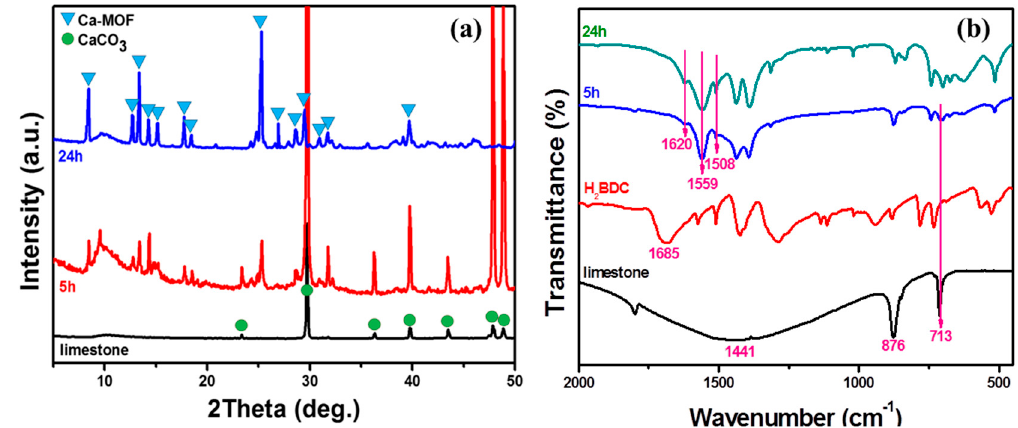
Figure 1. ( a ) XRD patterns and ( b ) FTIR spectra of limestone acidified in acetic acid at different acidification times with 10 M acetic acid to form Ca-based metal–organic framework (Ca-MOF)-5h- 10 and